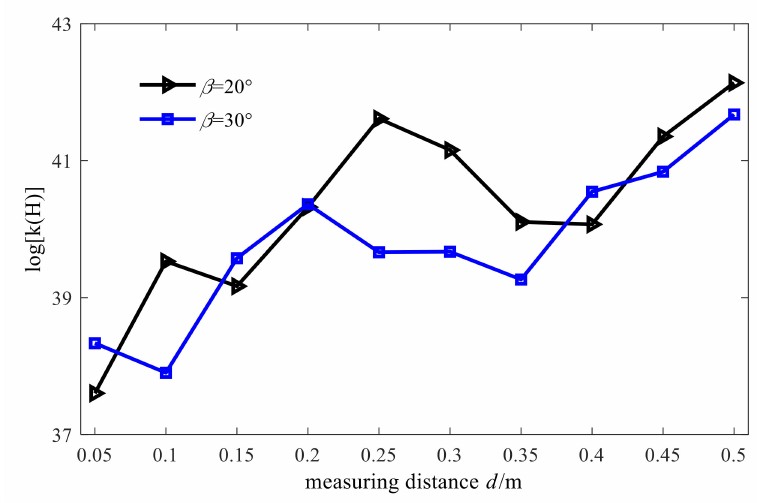
Figure 14. Influence of measuring distance on conditional number.